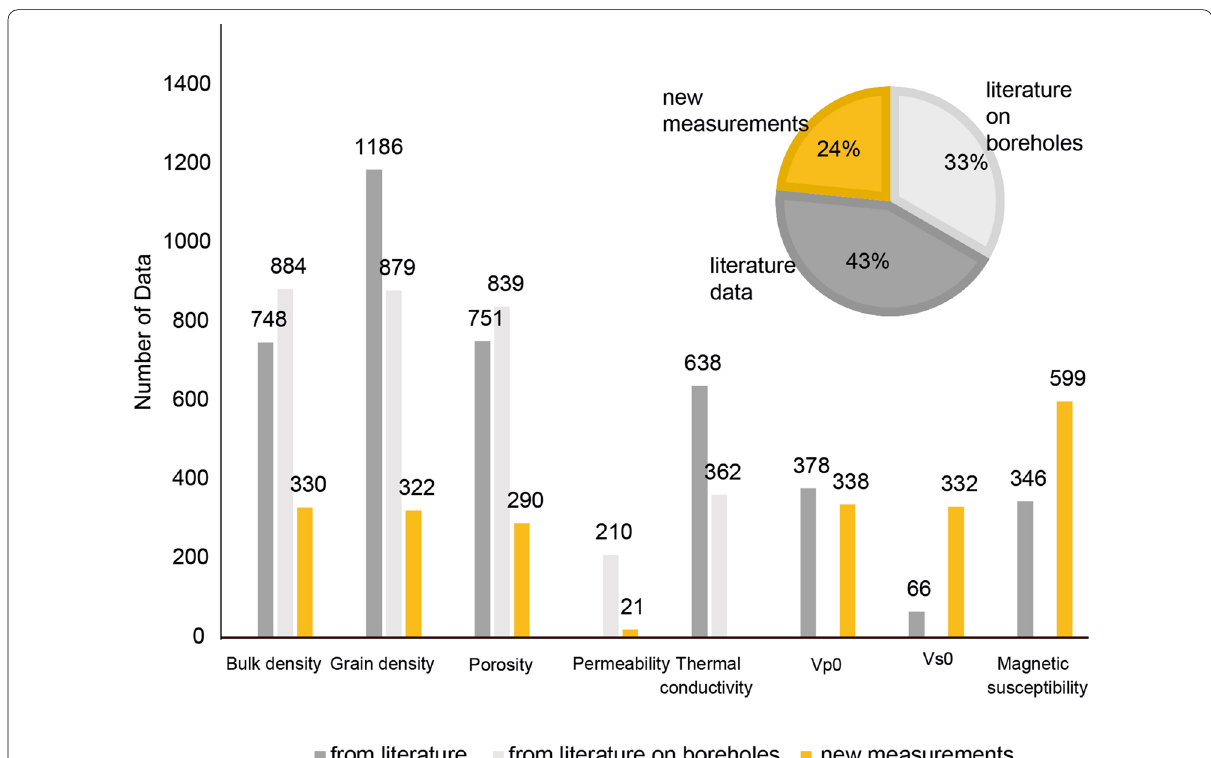
Fig. 4 Proportion of the different data sources. In term of absolute number of data, the main source is literature (scientific literature, public reports, industrial technical reports, Ph.D. theses, and other). In this figure we differentiate data from boreholes as explained in the text; almost all the borehole data derive from NAGRA public reports. Note that for some specific properties the contribution of the new measurements has been significant, as, f.e., for magnetic susceptibility. The numbers refer to data as of December